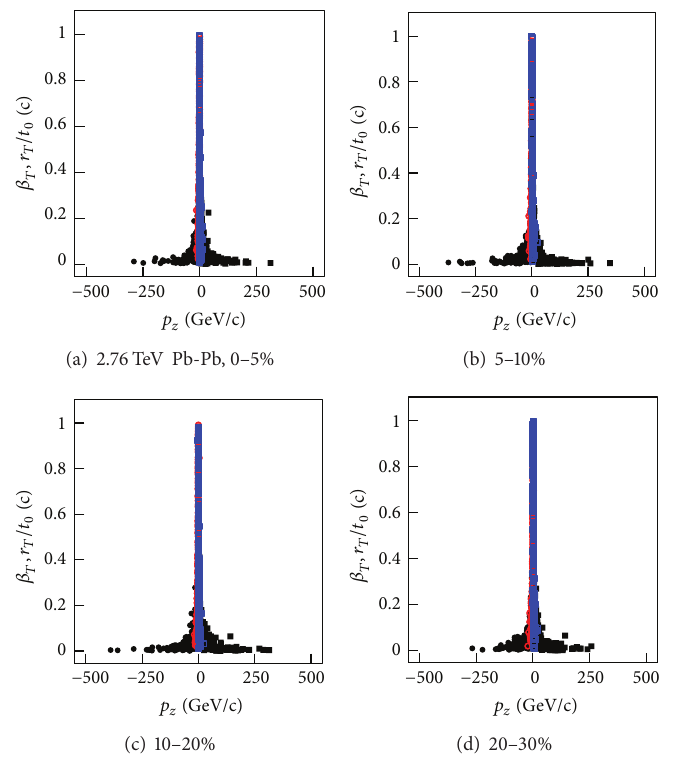
Figure 9: The same as for Figure 4, but showing the results in the space 𝛽 𝑇 − 𝑝 𝑧 (or 𝑟 𝑇 /𝑡 0 − 𝑝 𝑧 ).